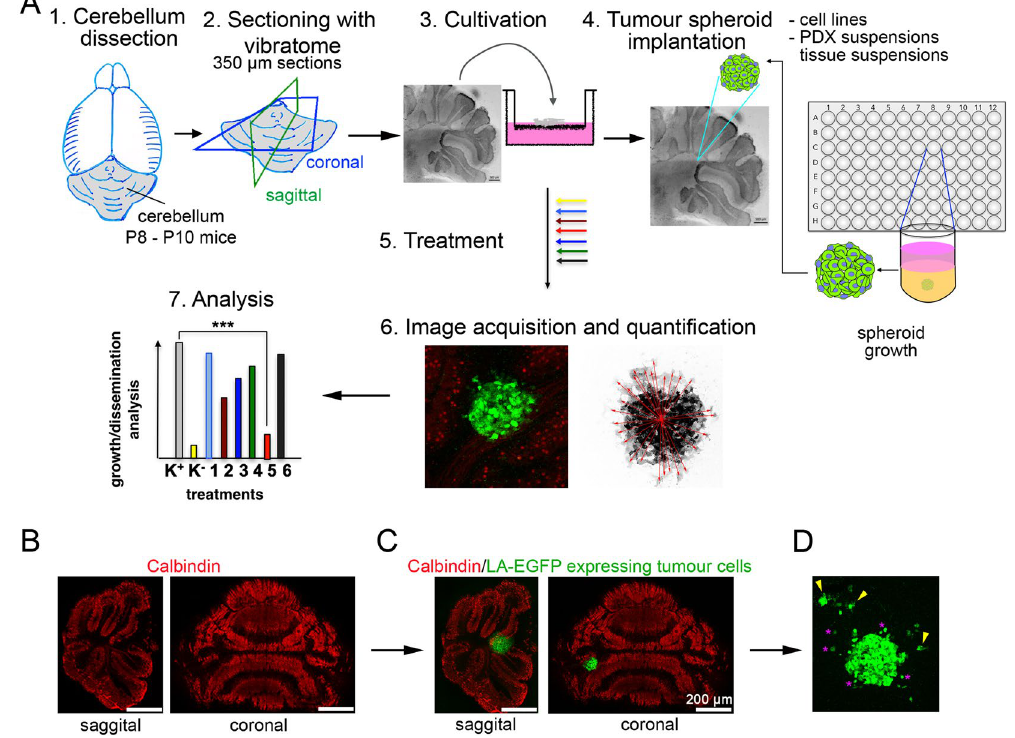
Figure 1. The organotypic cerebellar slice–tumour co-culture. (A) Workflow for OCSC generation and tumour spheroid implantation. (1) Decapitation of mouse pup(s) at PND 8–10 and isolation of cerebellum. (2) Sectioning of cerebellum under physiological conditions using a vibratome to generate 350 µ m thick sagittal or coronal sections. (3) Culture of cerebellum sections on membrane inserts for 15 days in vitro (DIV). (4) Implantation of one LifeAct enhanced GFP (LA-EGFP) expressing tumour spheroid per slice. (5) Further incubation of the co-culture in vitro without or with treatment. (6) Fixation and immunofluorescence for microscopy analysis. (7) Quantification and data analysis. ( B) Sagittal and coronal sections of cerebella, stained with anti-Calbindin (red) to visualise Purkinje cells. ( C) Implantation of LA-EGFP expressing DAOY cells spheroid on the slices. ( D) Dissemination of tumour cells (green) in the cerebellar slices after 5 days post initiation of